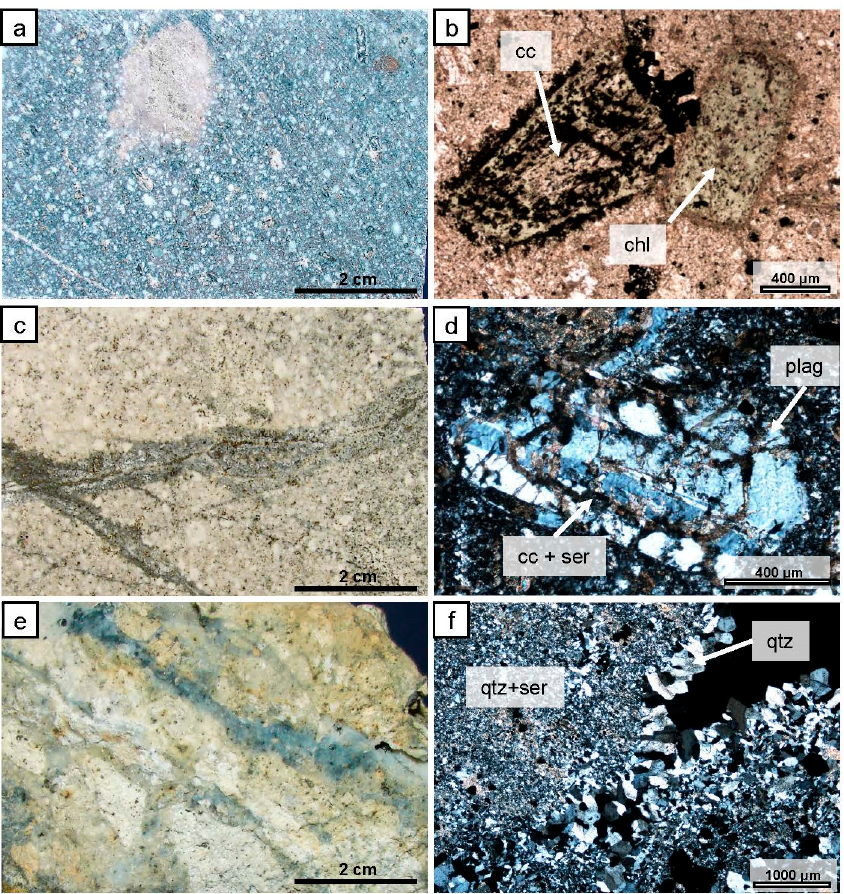
Figure 4. Examples of host rocks and alteration in the “Milligan samples” in hand specimen (left) and thin section (right). (( a , b ) sample BSSE-295B) Propylitic-altered diorite with relict phenocrysts of amphibole and plagioclase. The amphiboles have been altered to chlorite (chl), calcite (cc), and opaque minerals. (( c , d ) sample BSSE-2B) Sericite-carbonate-altered diorite with phenocrysts of plagioclase (plag). The plagioclase has been altered to sericite (ser) and calcite. (( e , f ) sample BSSE-333C). Silicic-altered vuggy diorite with sericite and quartz (qtz) alteration of the groundmass and drusy quartz filling vugs. The feldspar phenocrysts were poorly preserved, with only clusters of sericite remaining.